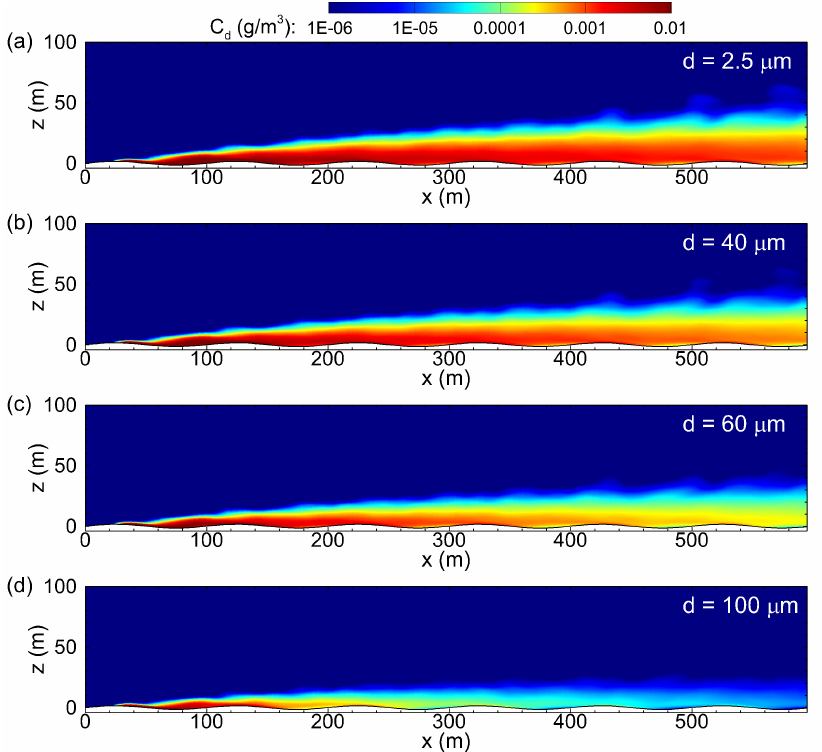
Figure 8. Time-averaged oil aerosol concentrations on the ( x , z ) -plane across the center of the surface release region for the flat-surface case: ( a ) d = 2.5 µ m; ( b ) d = 40 µ m; ( c ) d = 60 µ m; ( d ) d = 100 µ m.